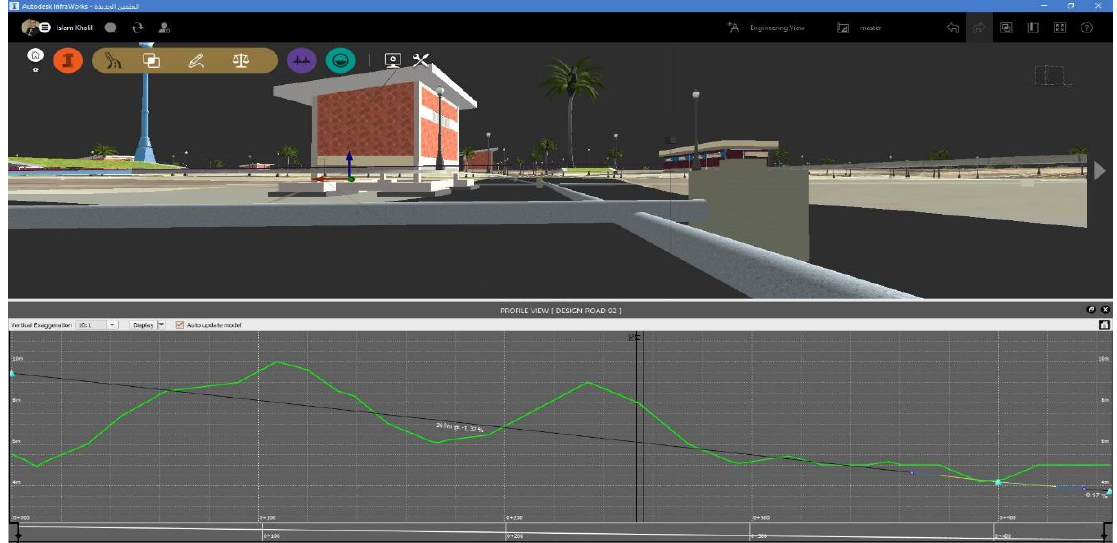
Figure 11: INFRA WORKS 360 (Networks –